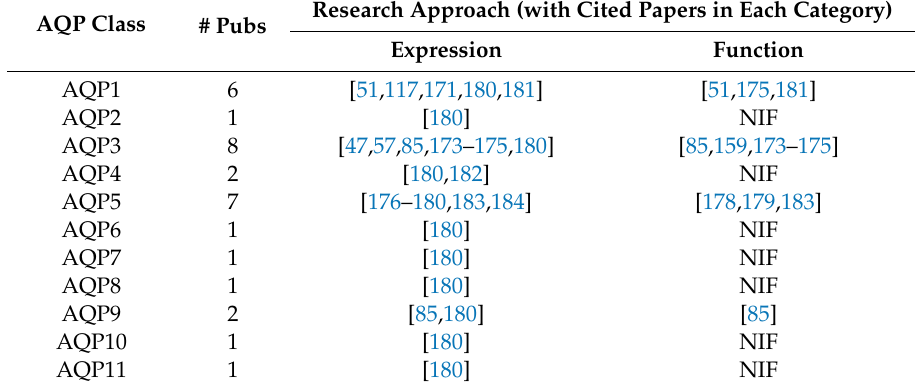
Table 5. Publications on AQPs in breast cancer, classified by research approach. Research Approach (with Cited Papers in Each # Pubs